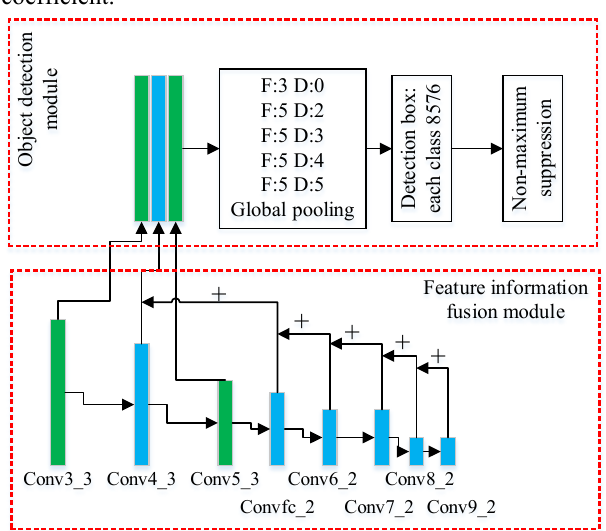
Figure 3. Proposed moving object detection